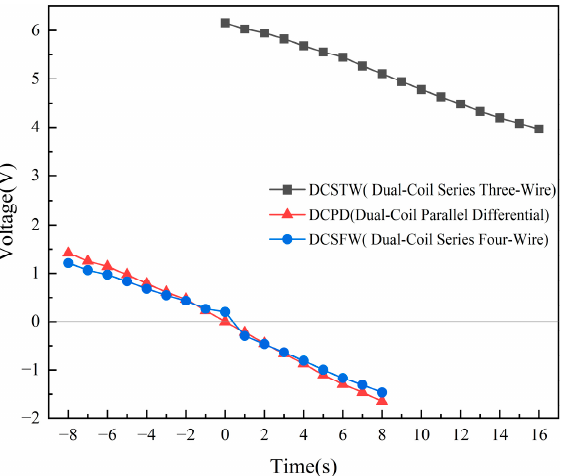
Figure 13. Comparison of the output signal of AD630 circuit under three excitation methods (before filtering).